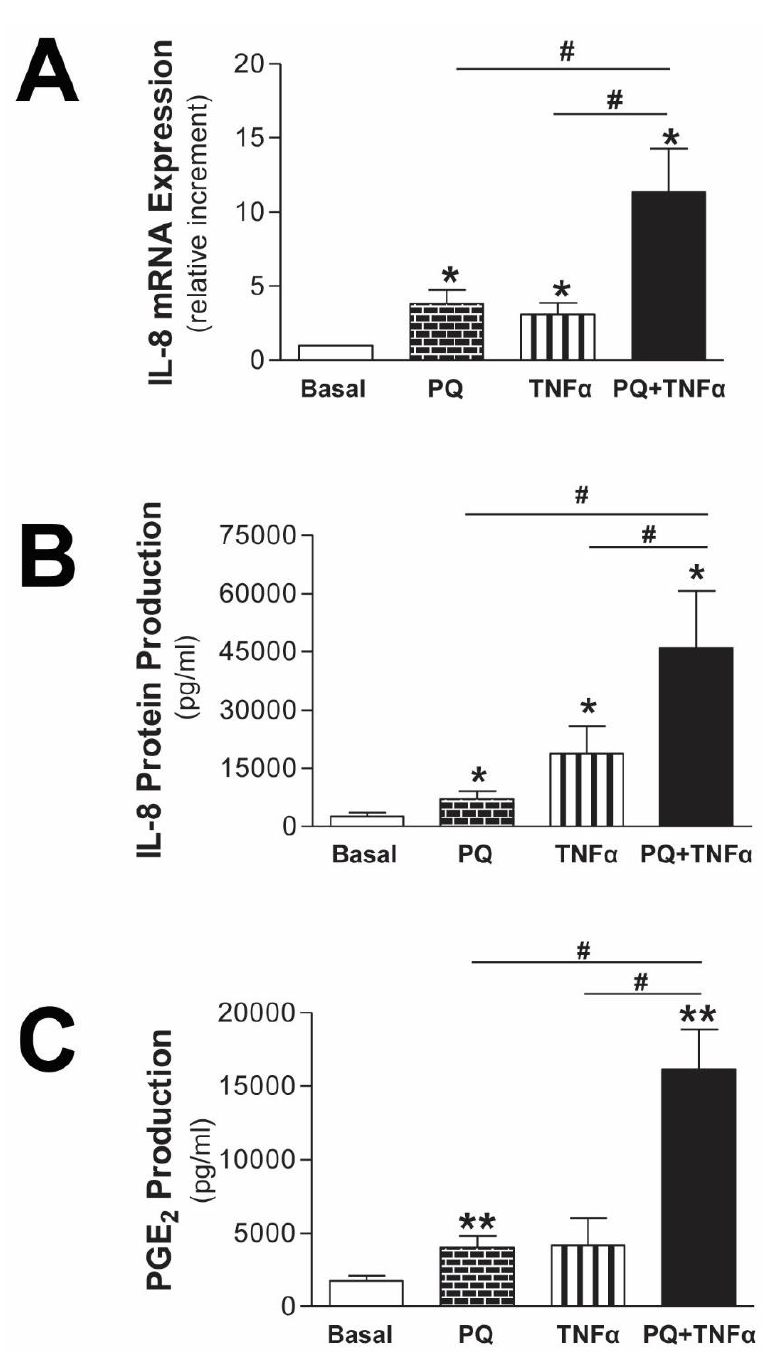
Figure 3. Mitochondrial dysfunction modulates IL-8 and PGE2 response induced by TNF α in human mesothelial cells from peritoneal effluent of PD patients. Mesothelial cells with epithelial phenotype were preincubated with the selective mitochondrial respiratory chain inhibitor paraquat (PQ; 1 mM) for 30 min before treatment with TNF α (1 ng/mL) for 18 h. ( A ) IL-8 mRNA expression is expressed as the mean ± SEM fold change vs. basal condition (n = 7). ( B ) IL-8 protein production is expressed as pg/mL (n = 7). ( C ) The concentration of PGE2 is expressed as pg/mL (n = 5). * p ≤ 0.05 and ** p ≤ 0.05 vs. basal, and # p ≤